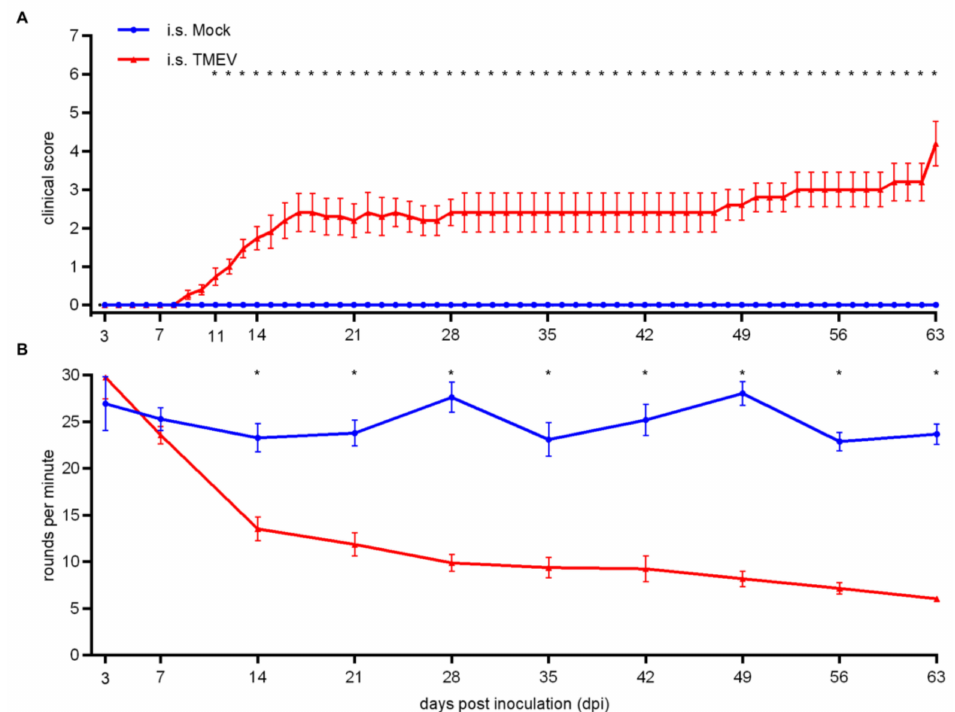
Figure 1. Clinical investigation including a rotarod performance of Swiss Jim Lambert (SJL) mice following intraspinal (i.s.) Theiler’s murine encephalomyelitis virus (TMEV) infection / mock-injection. After 11 days post infection (dpi), TMEV-infected animals showed significantly elevated clinical scores ( A ). Deterioration of motor coordination started at 14 dpi ( B ). Graphs display mean (solid line) and standard error of the mean (SEM). Significant di ff erences between the groups as detected by ANOVA followed by a Mann–Whitney U posthoc test are marked by asterisks (* p <